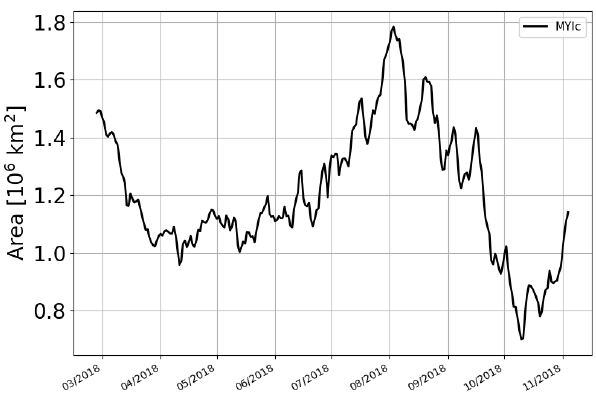
Figure 11. Time series of the total area of corrected MYI in the entire Antarctic from March to November